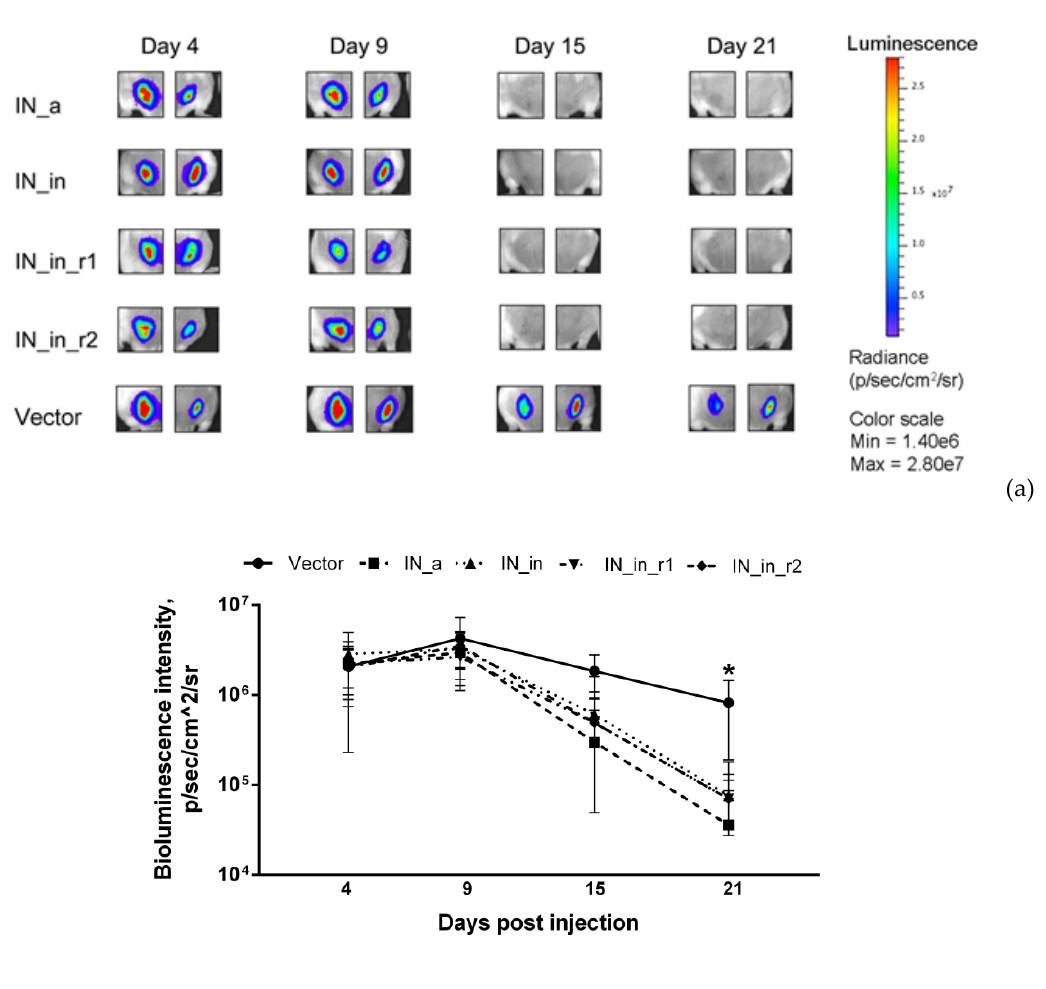
Figure 7. Immunization of mice with the plasmids encoding IN variants mixed with the reporter plasmid pVaxLuc results in rapid loss of photon flux from the sites of immunization. In vivo monitoring of luciferase activity at days 4, 9, 15, and 21 after the administration of plasmids encoding the consensus IN (IN_a), inactivated consensus IN (IN_in), inactivated consensus IN with raltegravir resistance mutations (IN_in_r1, IN_in_r2), or empty vector pVax1 (Vector), each mixed with Luc reporter gene (1:1) ( a ); change of photon flux reflecting Luc expression over time ( b ). Images demonstrate two representative injection sites per group followed throughout the immunization. The scale to the right represents the level of luminescent signal in pixels/sec/cm^2/sr. ( b ) Curves represent mean ± SD ( n = 8) (Table 1, Series I, II). *— p < 0.05 for BLI in vector-immunized mice versus all IN variants-immunized mice. Statistical analysis was performed by Kruskal–Wallis and Mann–Whitney